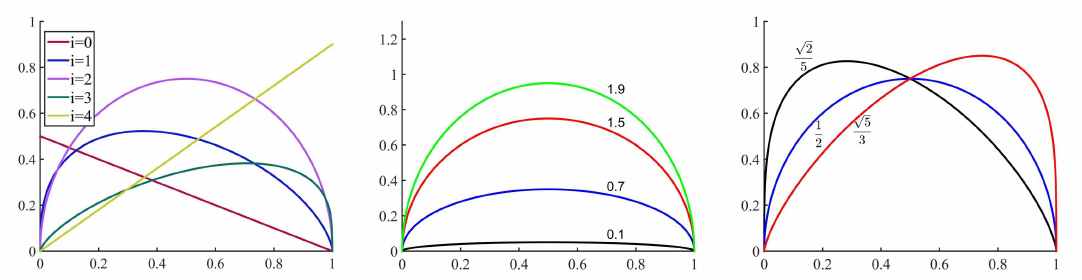
Figure 2: GT-Bernstein basis. Figure 3: Effect of coefficient